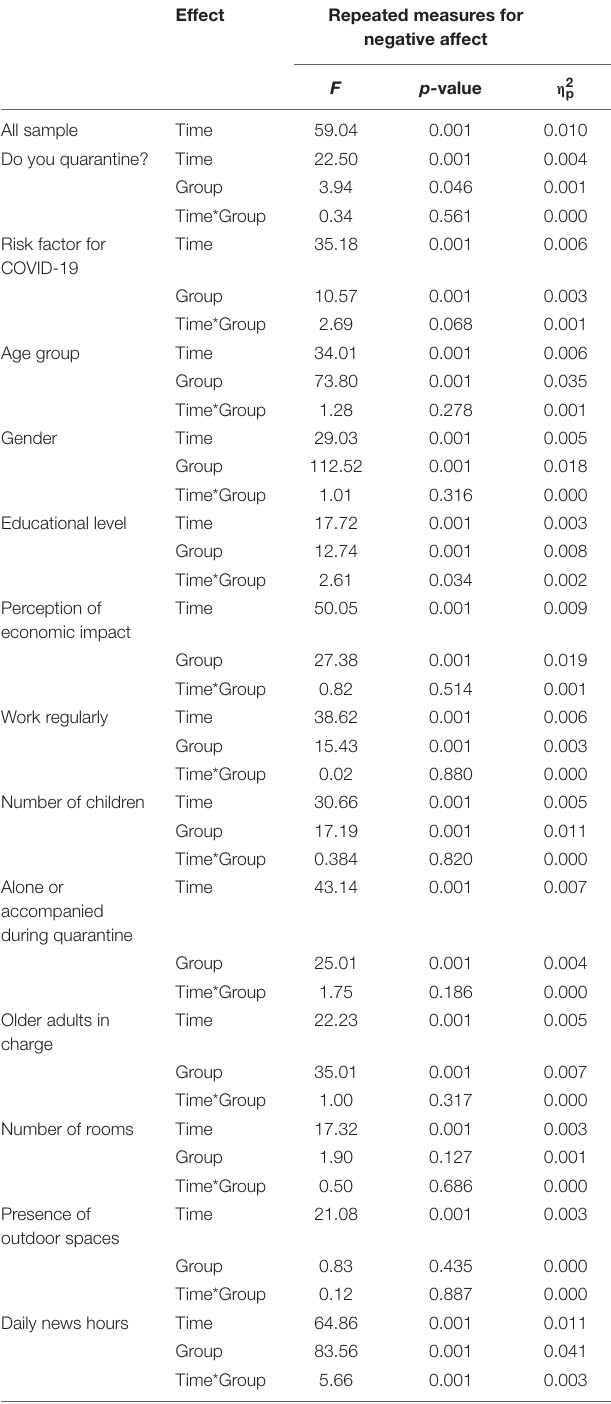
TABLE 7 | Results of repeated measures ANOVA for negative